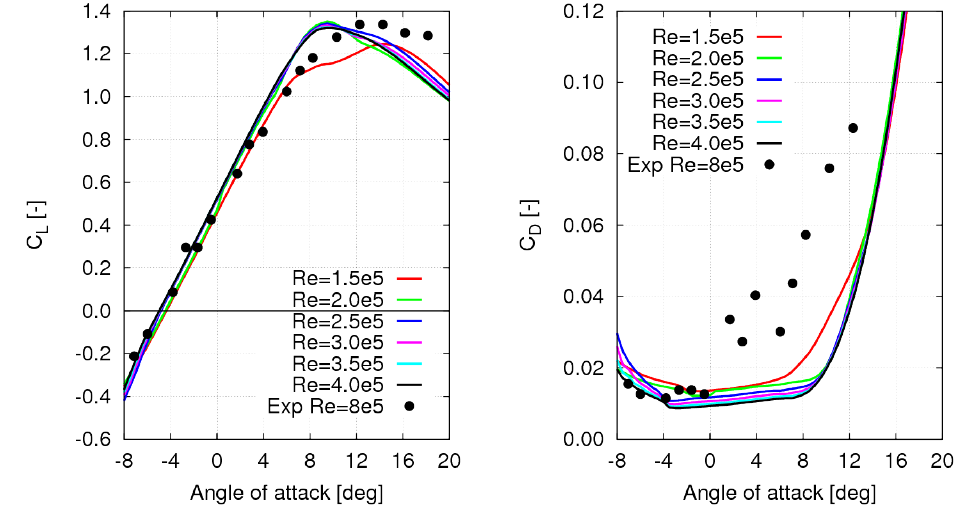
Figure 22. NACA 63-815 2D foil: lift ( left ) and drag ( right ) coefficients used for the viscous flow correction of